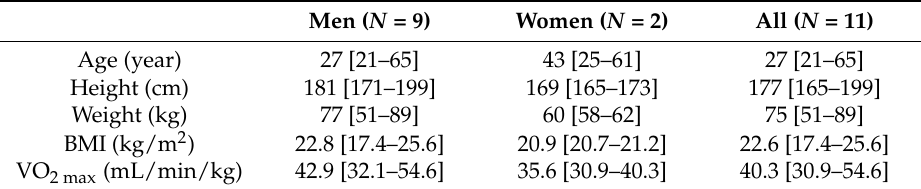
Table 1. Characteristics of included participants (median [range]).